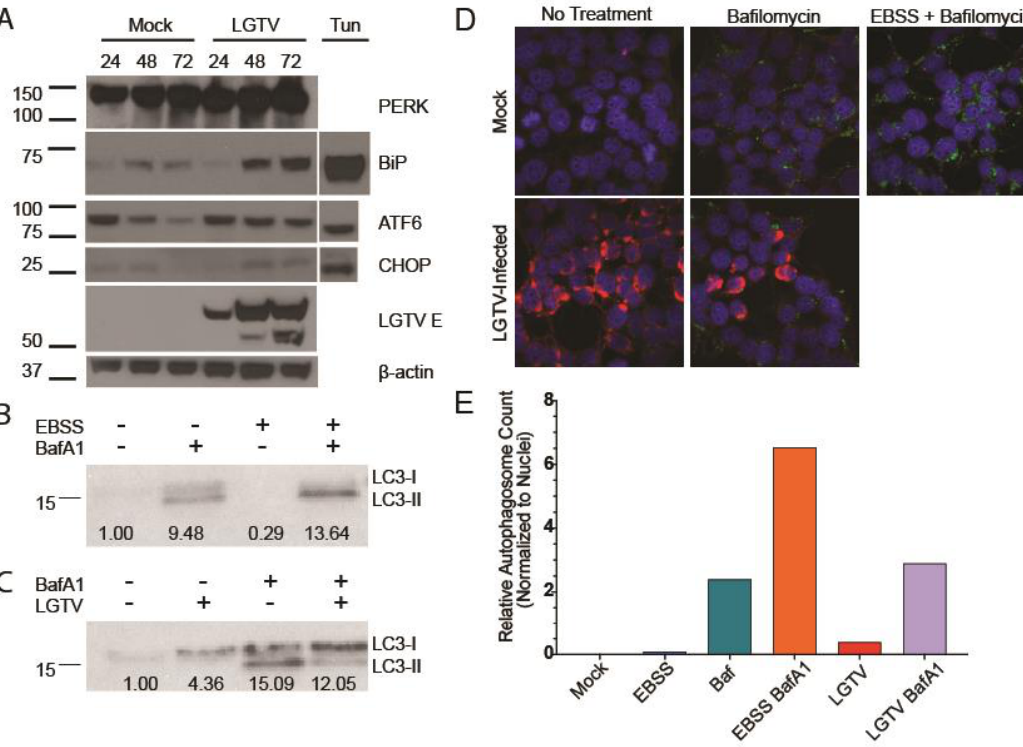
Figure 1. The tick-borne flavivirus Langat virus (LGTV) infection activates host unfolded protein response (UPR) and autophagy pathways. ( A ) LGTV infection (MOI = 10) in HEK293T cells generated an increase in binding immunoglobulin protein (BiP) and CCAAT-enhancer-binding protein homologous protein (CHOP) expression, but not activating transcription factor 6 (ATF6) cleavage, suggesting active protein kinase R-like endoplasmic reticulum kinase PERK signaling. Tunicamycin (10 µg/mL) control included for BiP, ATF6, and CHOP. LGTV E expression increased throughout infection time course. ( B ) Basal autophagic flux of HEK293T cells measured by microtubule-associated protein light chain 3 (LC3)-I and LC3-II expression. Earle’s balanced salt solution (EBSS) starvation increases flux, depleting LC3-I and LC3-II. Blocking autolysosomal degradation with bafilomycin A1 (BafA1) increased the abundance of LC3-II, more so under EBSS starvation. Total signal normalized to mock control and reported below bands. ( C ) LGTV infection (MOI = 10) alters autophagic flux in HEK293T cells 24 hpi (hours post infection). Infected samples had higher overall LC3 expression, but the majority was unlipidated LC3-I, suggesting inhibition of LC3 lipidation. ( D ) Representative images of HEK293T cells treated with EBSS, BafA1, or LGTV infection. DAPI represented in blue, LC3 in green, and LGTV NS3 in red. Images acquired at 63x magnification. ( E ) Average autophagosomes per cell identified by LC3 fluorescent signal normalized to number of nuclei. Very few autophagosomes recorded in non-BafA1-treated samples.